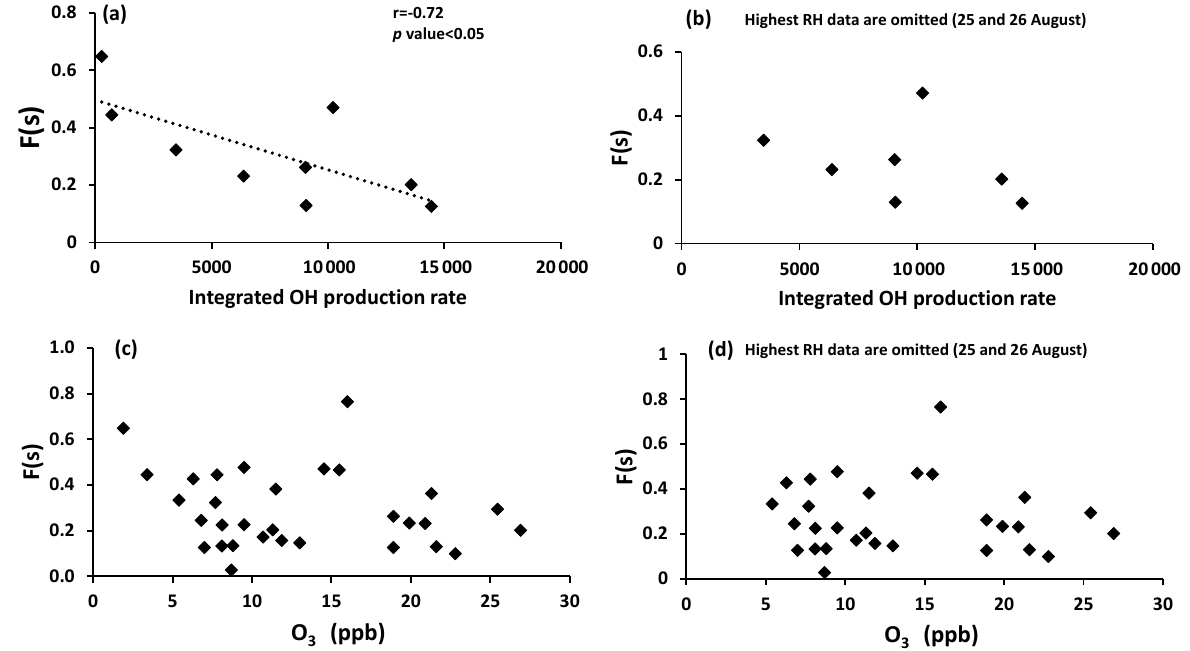
Figure A2. Sulfur conversion ratio F(s) versus (a) integrated OH production rate for all available daytime data, (b) integrated OH production rate when 25 and 26 August data with highest RH are omitted, (c) O 3 with daytime, nighttime, and daily data, and (d) O 3 with all data when 25 and 26 August data with highest RH are